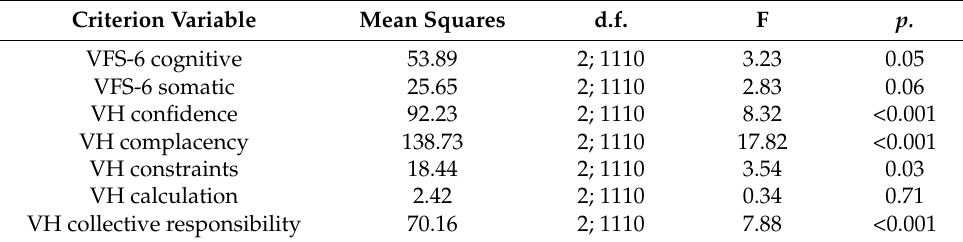
Table 2. One-way ANOVA analyzing the differences between COVID-19-related